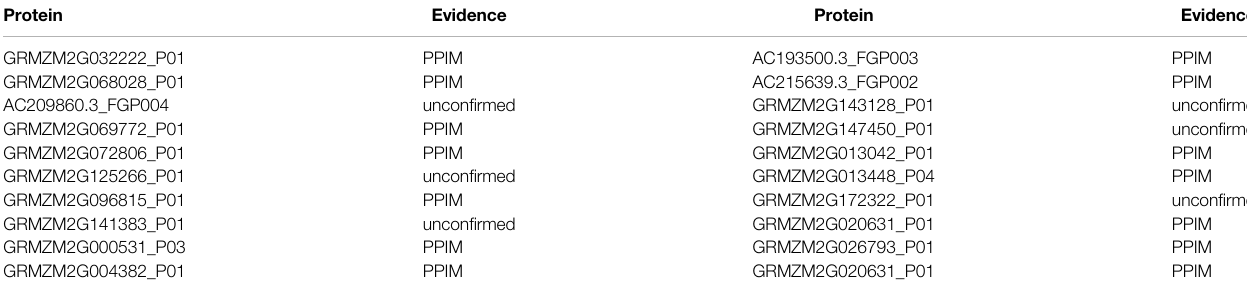
TABLE 6 | Prediction of the top 14 predicted proteins based on known interactions on the Zea mays dataset.